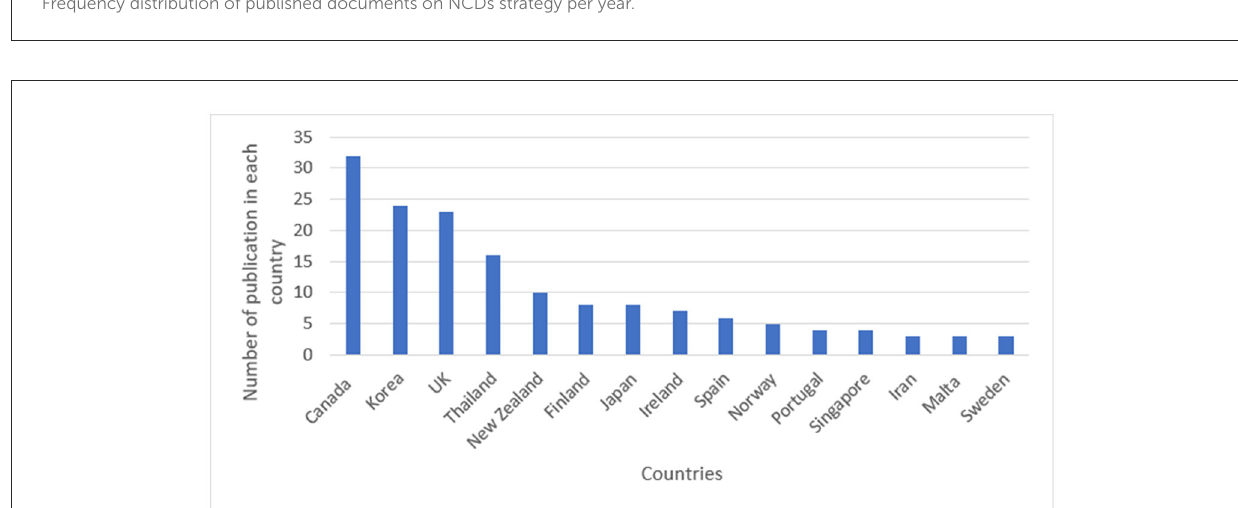
FIGURE2 Frequency distribution of published documents on NCDs strategy per year.